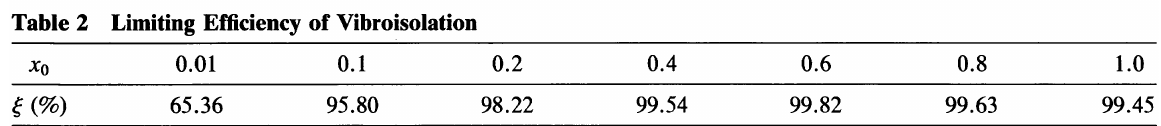
Table 2 Limiting Efficiency of